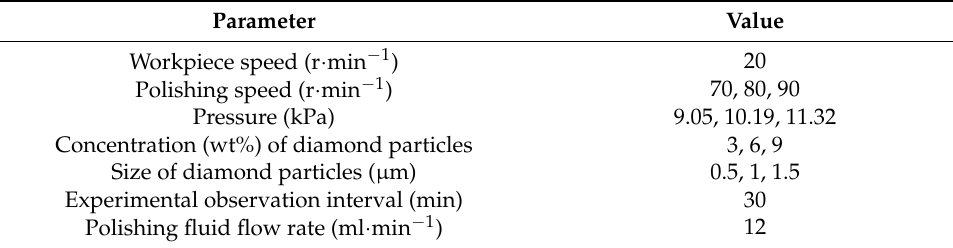
Table 2. SRP Table 2. SRP parameters.